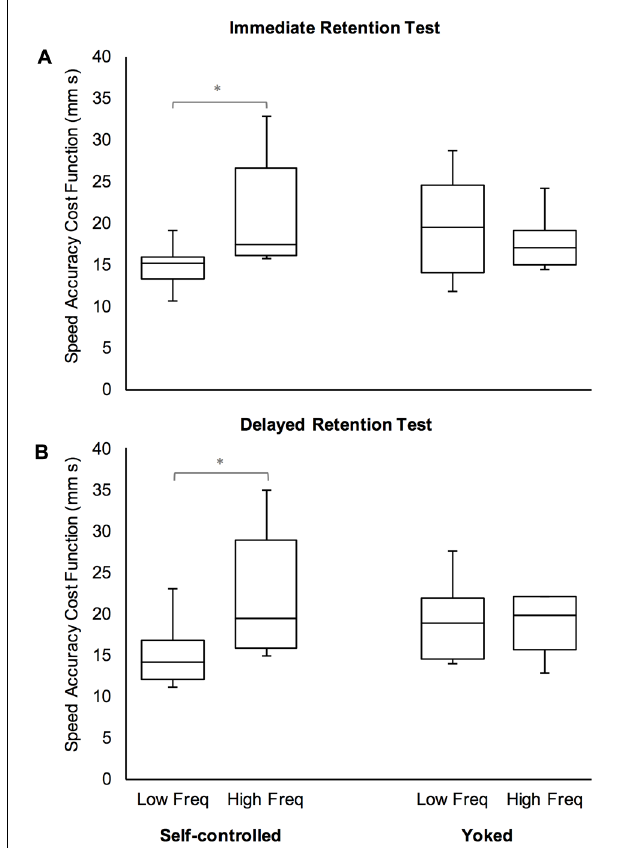
FIGURE 4 | Box and whisker plots of performance efficiency (as measured by the speed accuracy cost function) for immediate (A) and delayed (B) retention tests, by experimental group and frequency of haptic assistance during skill acquisition. “Low Freq” refers to participants who practiced with a low frequency of haptic assistance (four or fewer blocks) while “High Freq” refers to participants who practiced with a high frequency of haptic assistance (more than four blocks). ∗ p < 0.05.